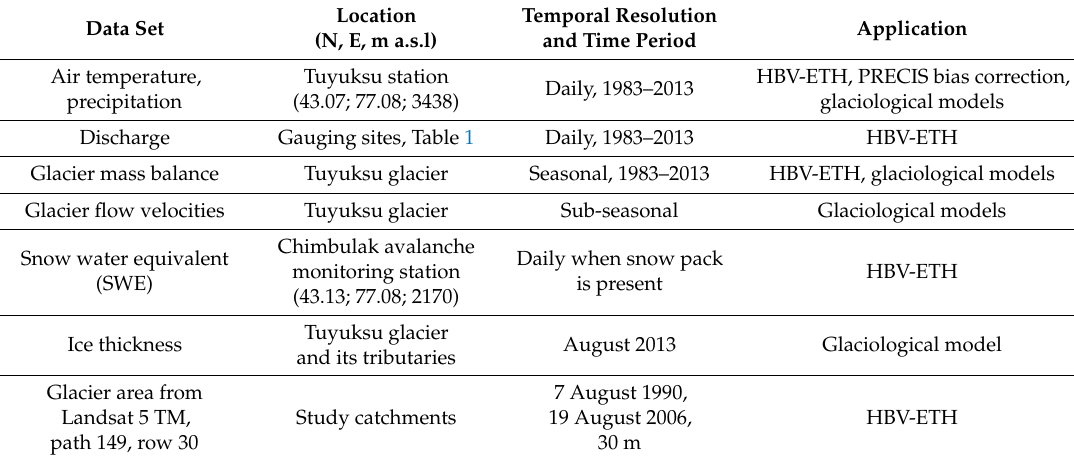
Table 2. Observational data